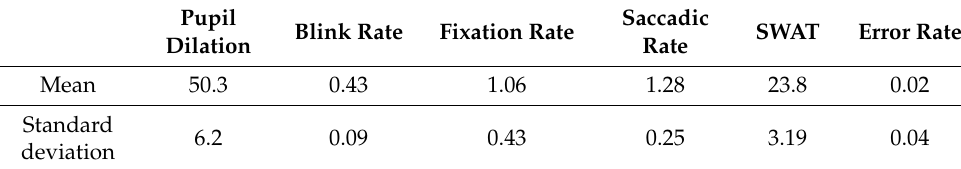
Table 4. The evaluation results of all indices.